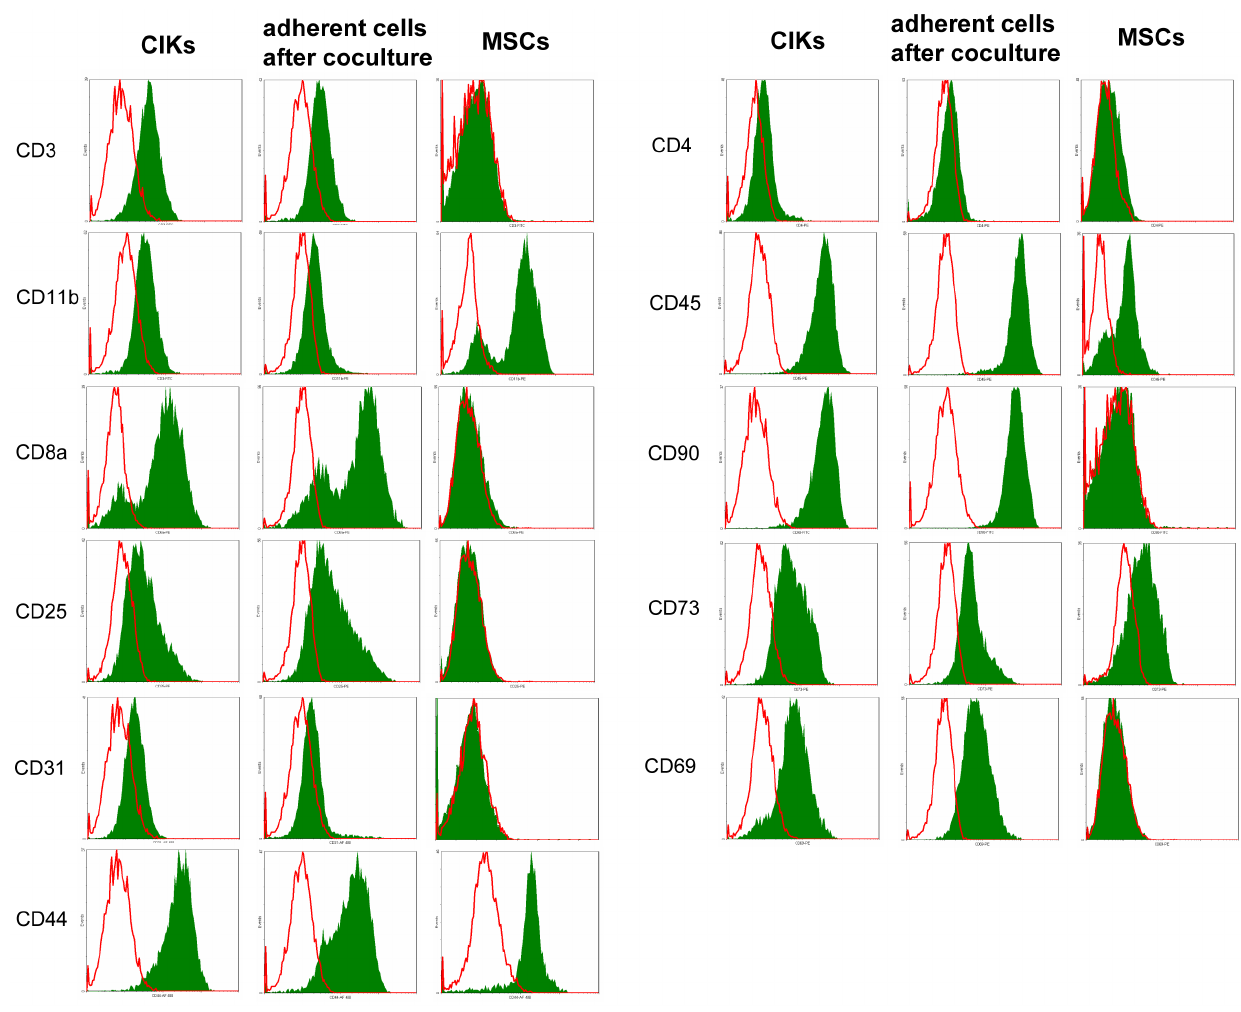
Figure 7. Comparison phenotypes: CIKs – adherent cells after coculture - MSCs. After 7 days of CIK/MSC coculture (day 14), adherent cells were harvested separately from suspended cells and analysed using flow cytometry. In addition, 14-day-old MSCs and CIKs were harvested and analysed for the same markers. Adherent cells after coculture (column in the middle) display the phenotype of CIKs (left column) and differ considerably from the phenotype expected for MSCs (right column).